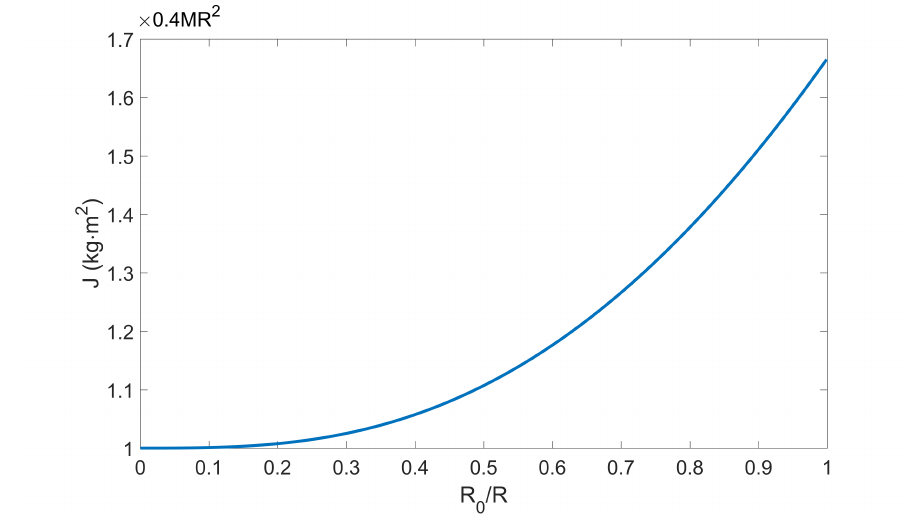
Figure 1. MOI of a hollow sphere with a fixed amount of